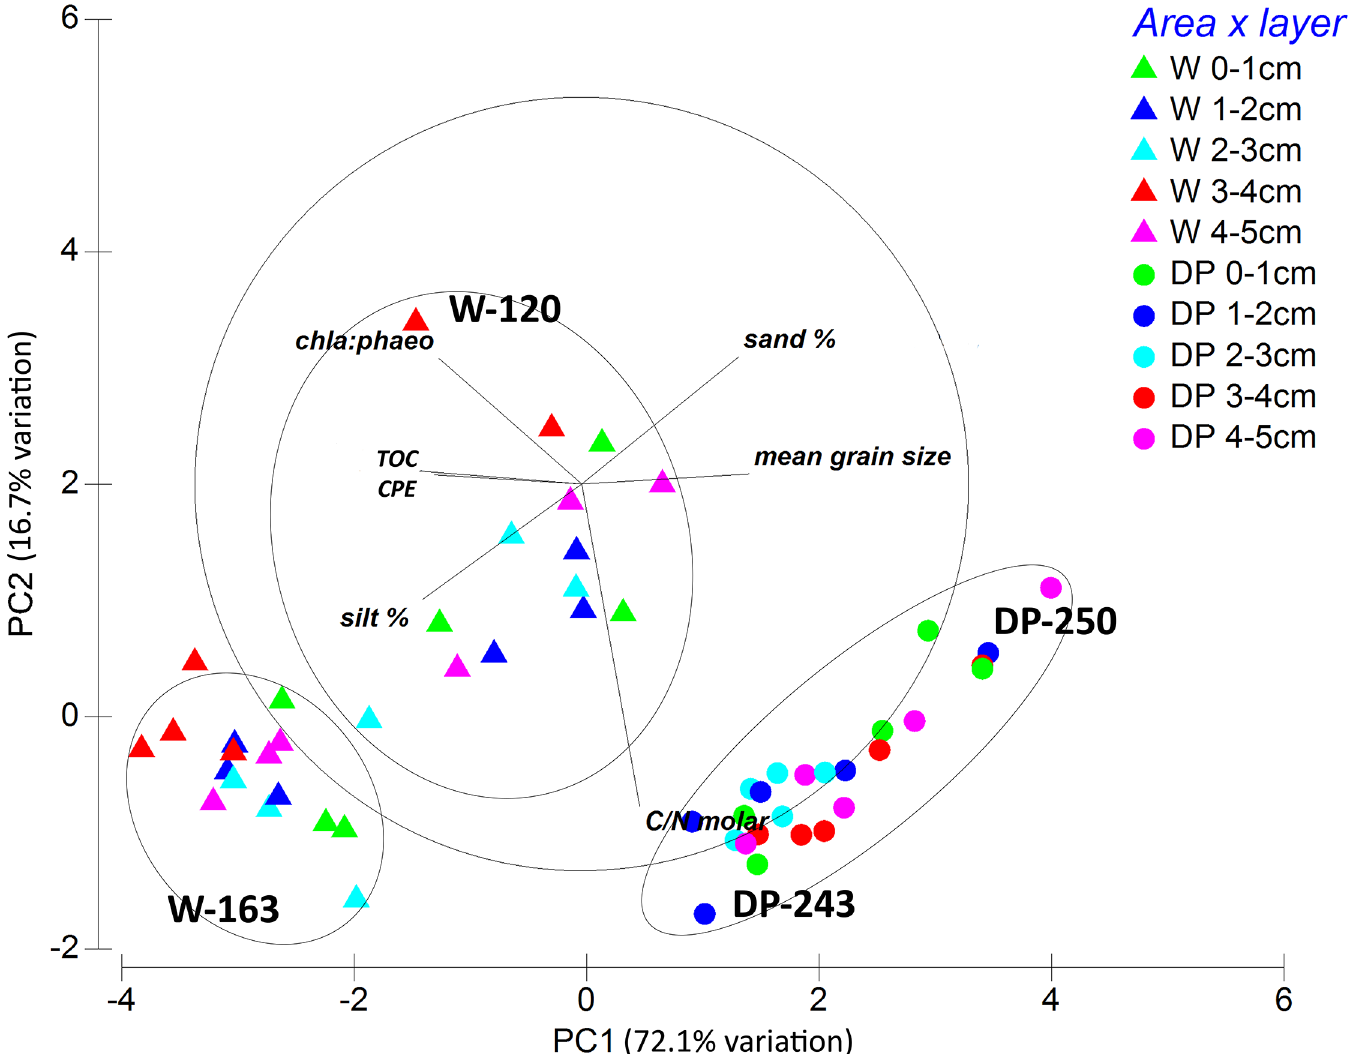
Fig 3. PCA plot of environmental data. Each symbol corresponds to a centimetre layer of a different replicate in Weddell Sea or Drake Passage and represents the environmental setting for that